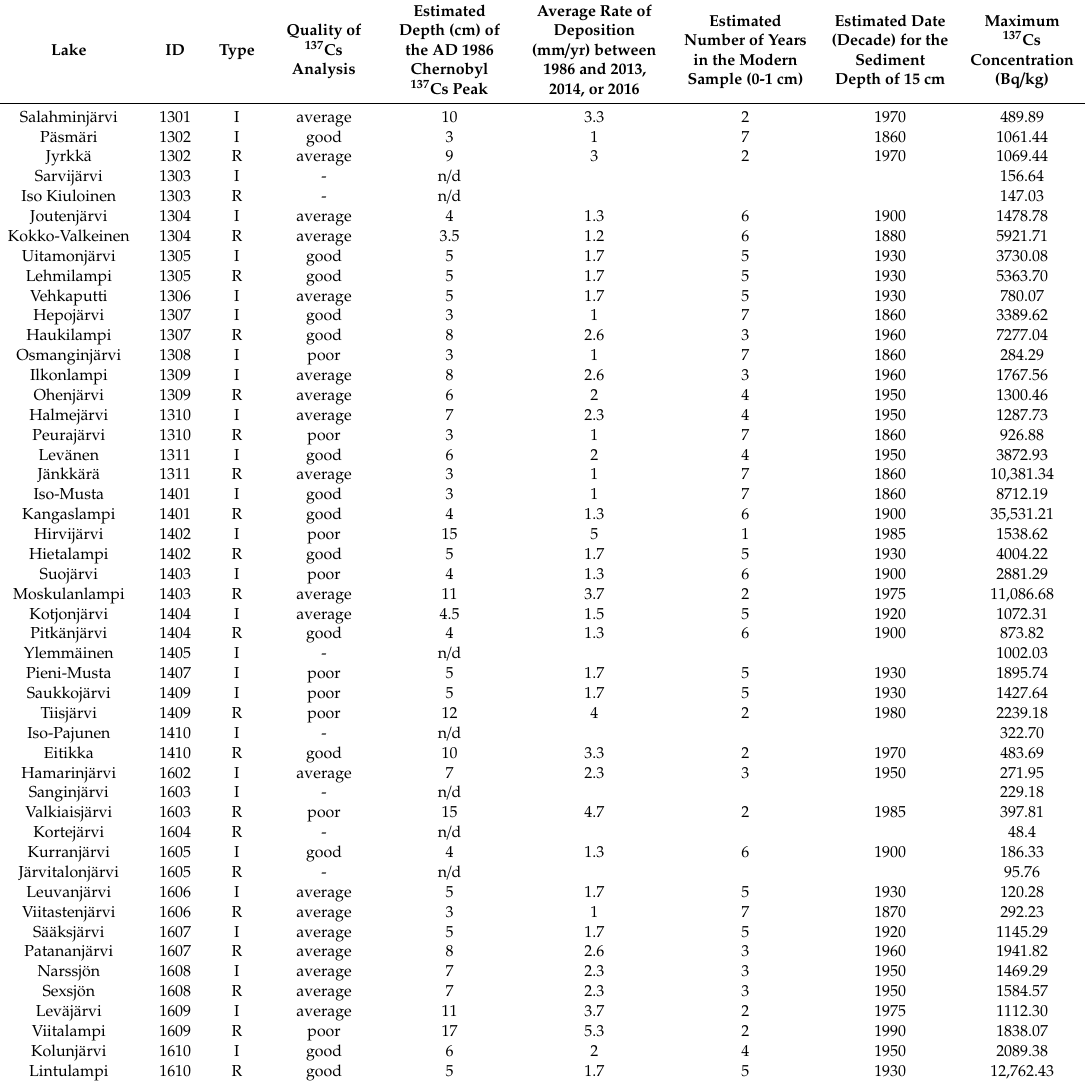
Table A2. Quality classification of 137 Cs dating, estimates for di ff erent sediment age–depth levels, and the rate of deposition for pre- and post-1986 sediments in the studied impacted and reference